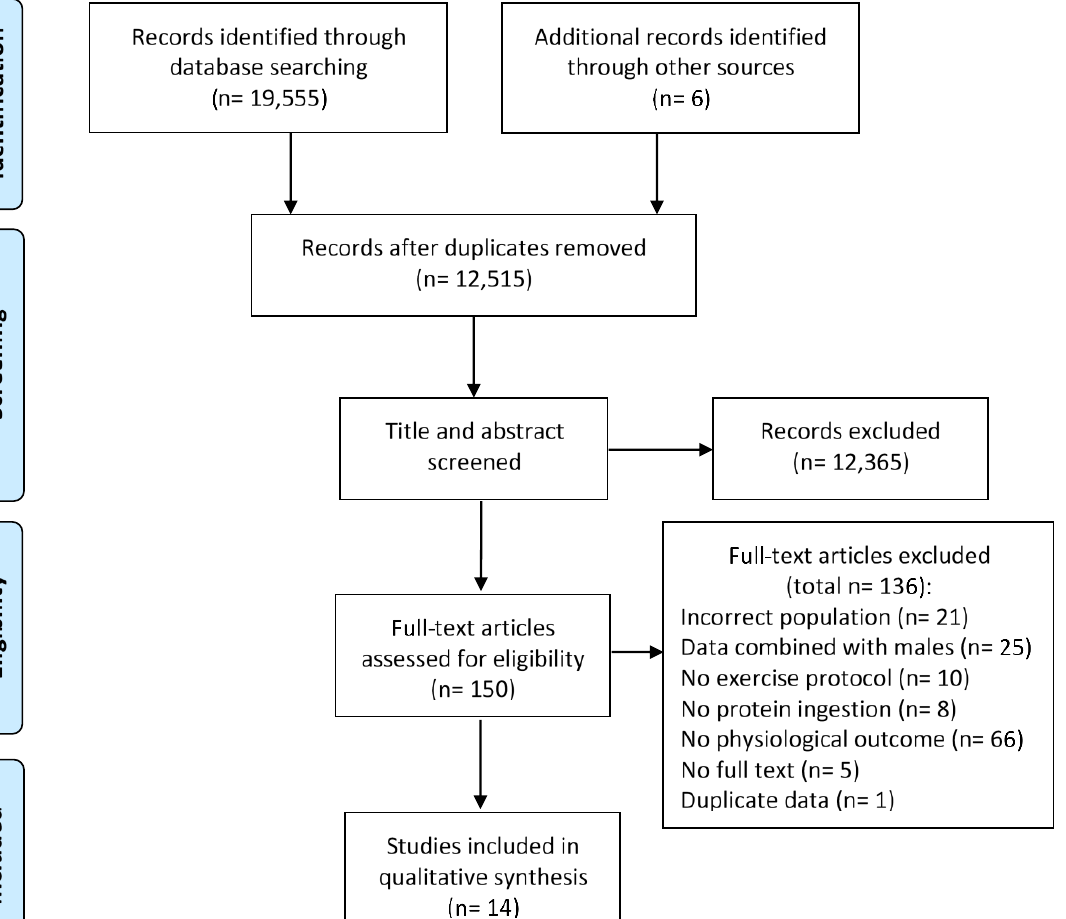
Figure 1. Search and screening flow diagram.